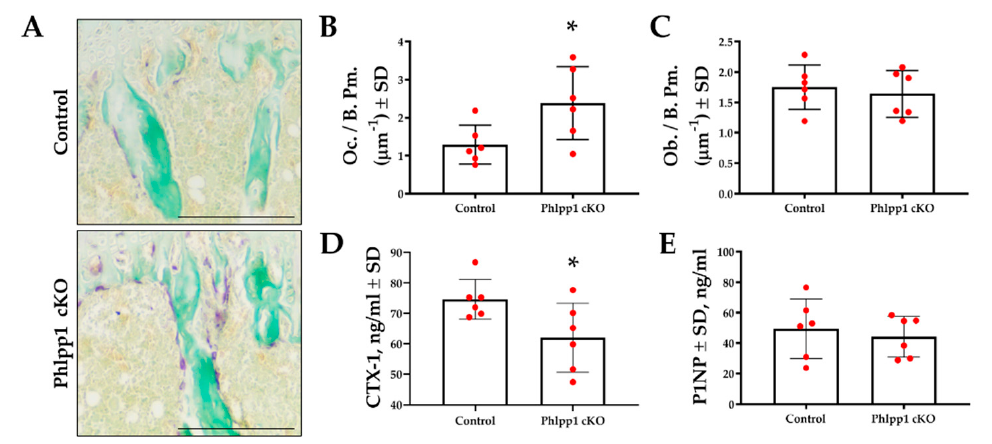
Figure 2. Conditional deletion of Phlpp1 increases osteoclast number, but reduces bone resorption. Female Phlpp1 cKO LysM mice and control littermates were aged to 12 weeks and paraffin sections were collected. TRAP staining was performed ( A ) and the number of osteoclasts per bone perimeter ( B ) was determined. Scale bar is 500 microns. * p < 0.05. Sections were Goldner’s trichrome stained and numbers of osteoblasts per bone perimeter were determined ( C ). CTX-1 ( D ) and P1NP ( E ) ELISAs were performed using serum collected from 12-week-old female mice. * p < 0.05.